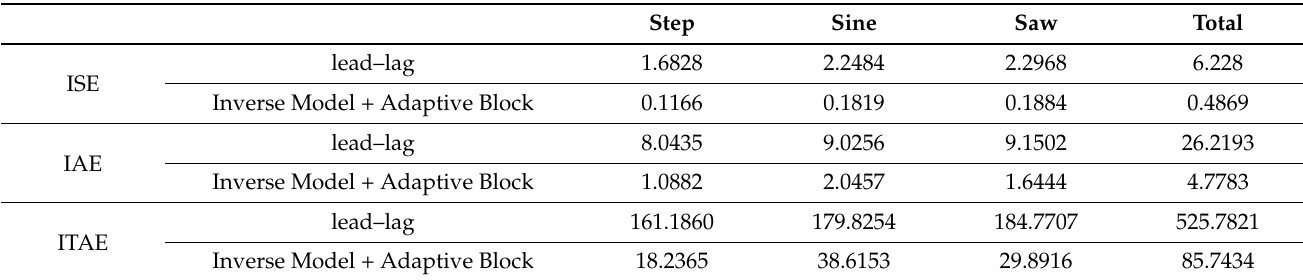
Table 10. ISE, IAE and ITAE values for the lead–lag and the Inverse model with adaptive block.